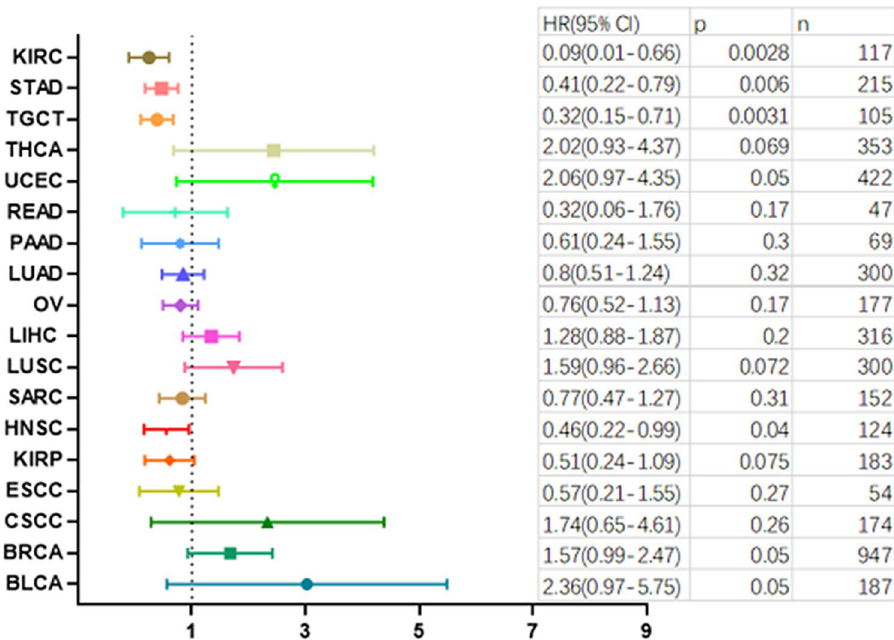
Figure 8. The relationship between MEK1 expression and patient progression-free survival